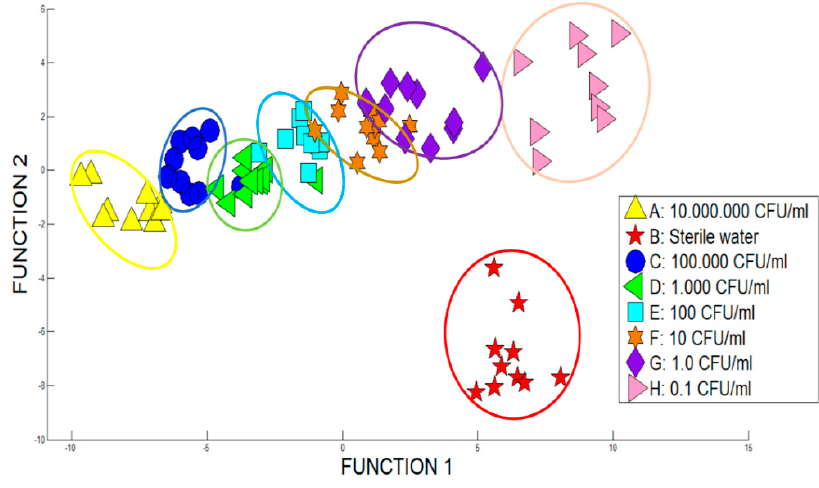
Figure 6. DFA chart of sterile water and different concentrations of E. coli .